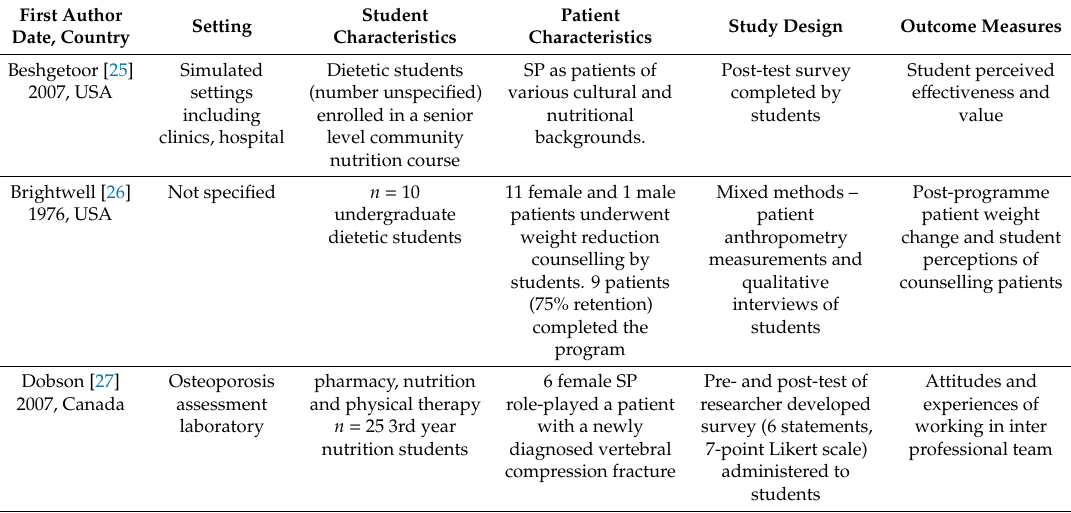
Figure 2. Study flow diagram. Table 1. Study characteristics of included studies.